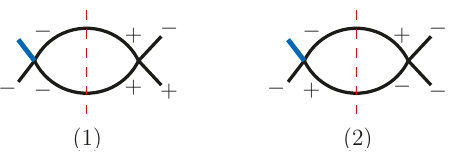
Figure 5 . The helicity changing amplitude vanishes for 4-dimensional